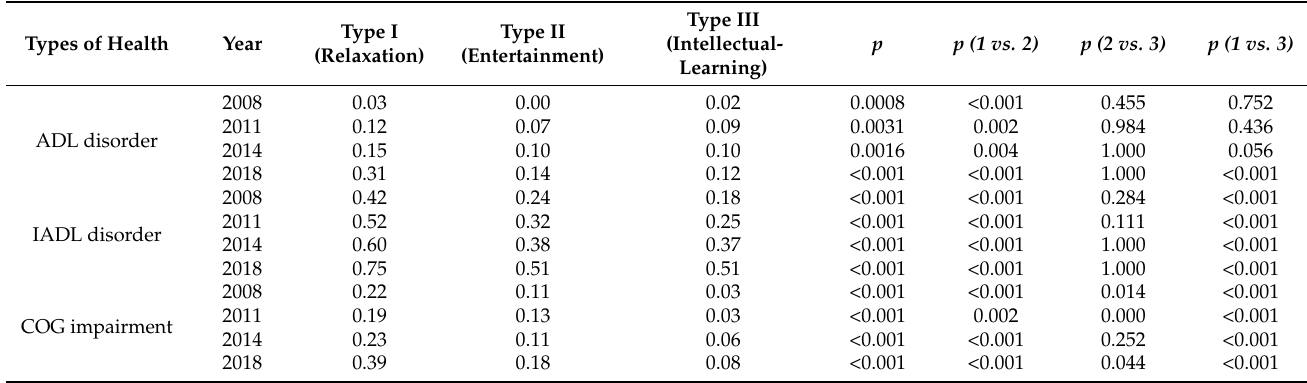
Table 6. Difference analysis of the impact of latent classification of leisure activities on the health status of older